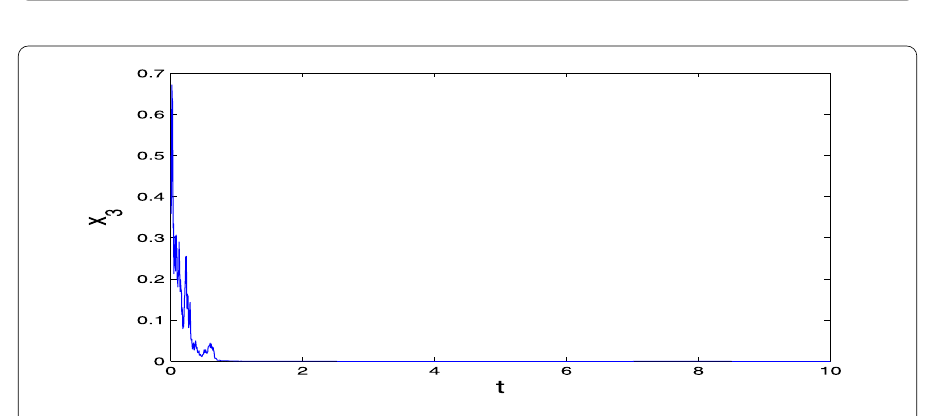
Figure 7 Stochastic trajectory of x 3 ( t ) for system